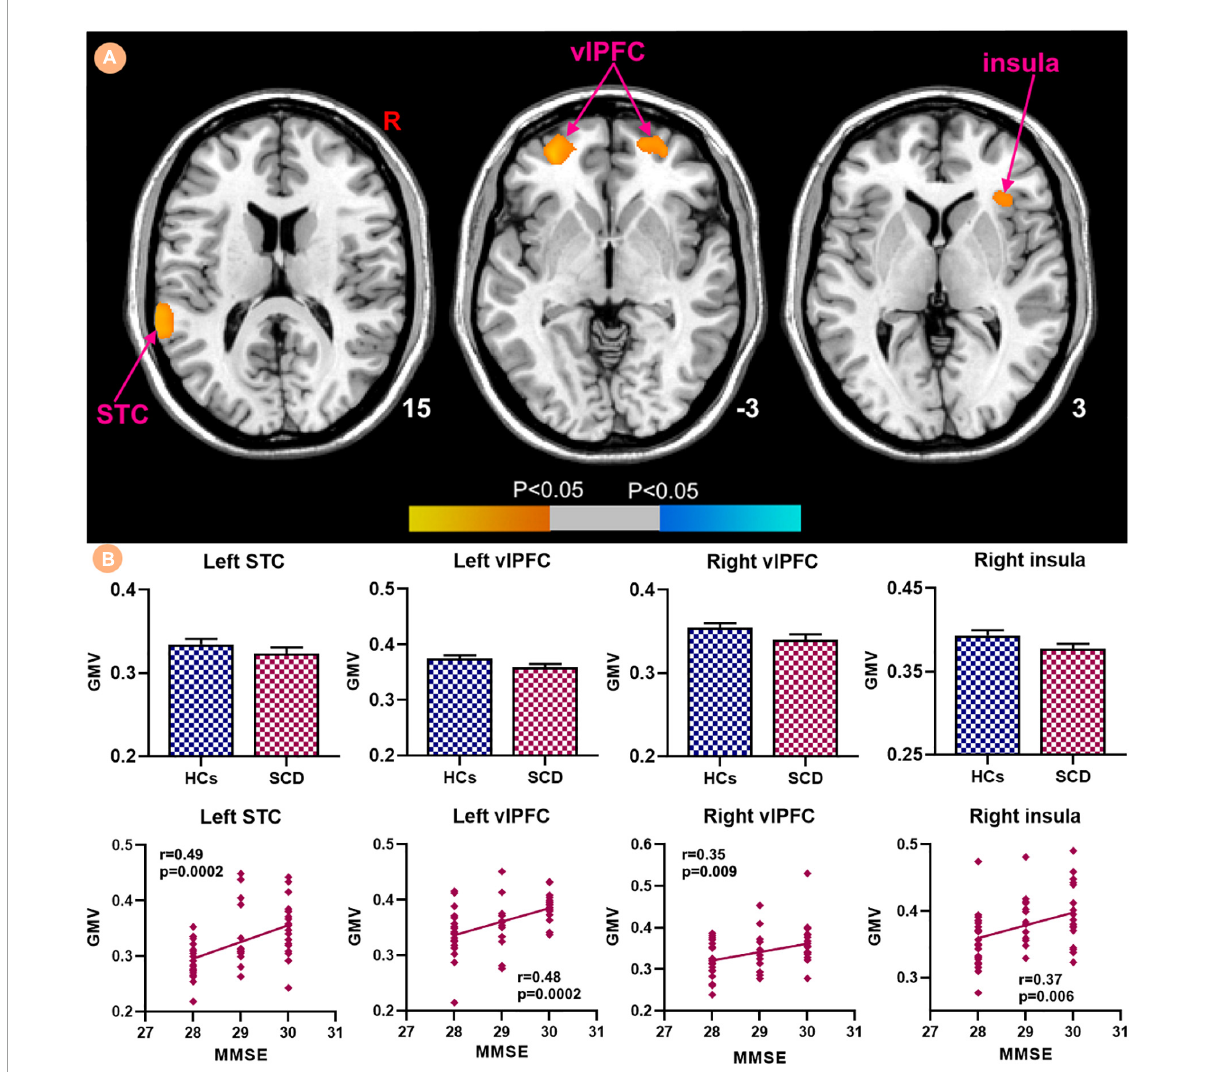
FIGURE4 Relationships between the GMV and MMSE in subjective cognitive decline (SCD) patients. (A) GMV covarying with MMSE in patiens with SCDs. Brain regions marked by warm color represent positive correlation and brain regions marked by cool color represent negative correlation. (B) Extracted GMV values and positive correlations between the MMSE and brain regions including left STC, bilateral vlPFC and right insula [mean ± standard error of mean